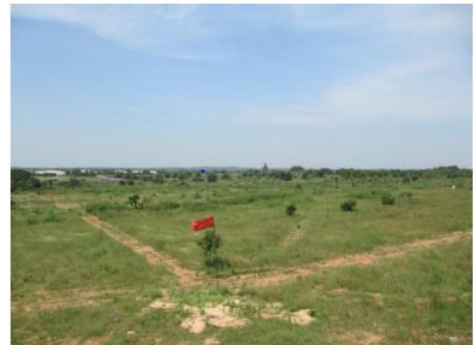
Figure 6. Site area before development..